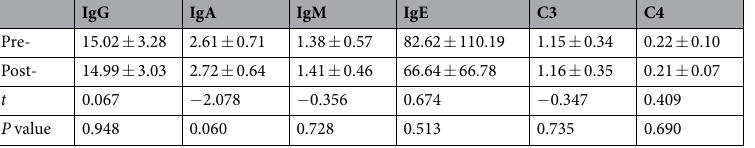
IgG IgA IgM IgE C3 C4 Pre-